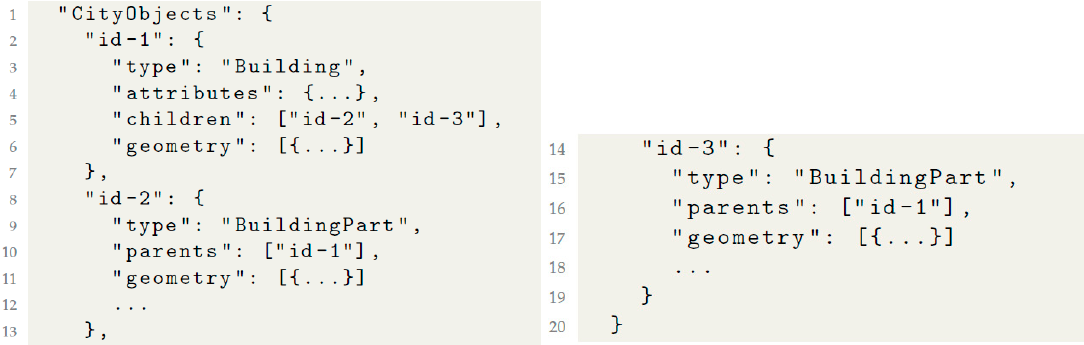
Figure 3. Examples a CityJSON implementation of a building with two parts, from [28].